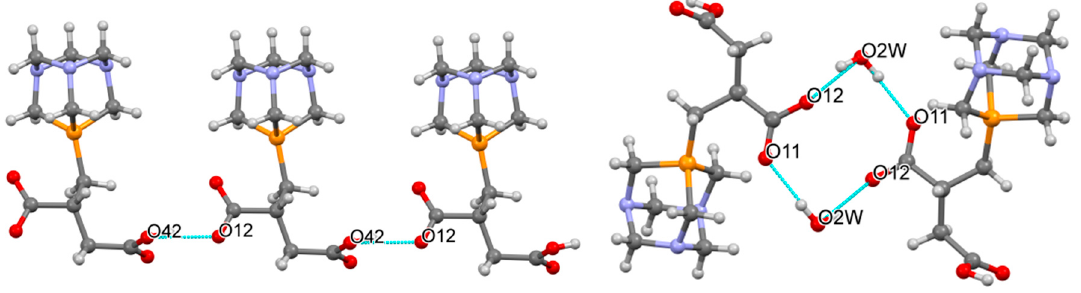
Figure 6. Partial packing view of 2. ( Left ): Hydrogen bonds between the PTA units. ( Right ): The connection between PTA units via H 2 O molecules (Bond lengths (Å): O42–H...O12 (ii) = 2.515(7), O2W–H...O12 (iii) = 2.806(8), O2W–H...O11 (ii) = 2.725(8), [Symmetry codes: (ii) 1 + x,y,–1 + z (iii) 2 − x,1 − y,1 − z]).